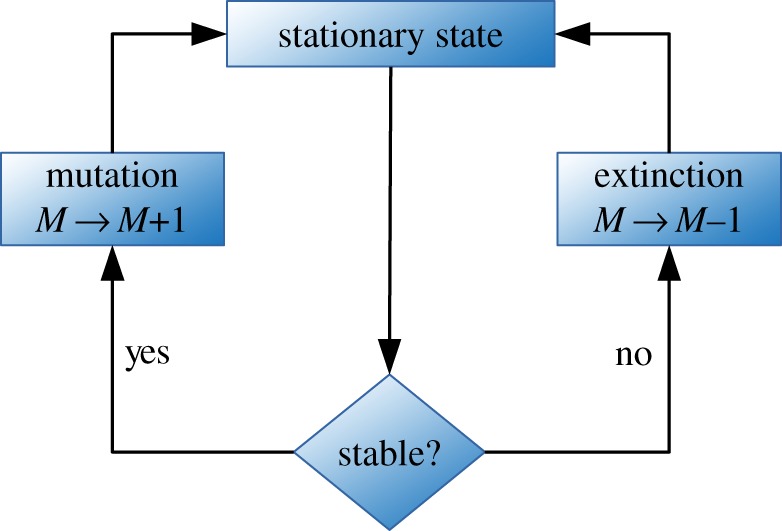
Schematic algorithm for the long-term population dynamics. First, we compute the stationary state of the short-term system according to equation (3.1). Then, we check the stability of the fixed point using the criteria in equation (3.2). If the fixed point is stable (i.e. mating types coexist), a mutation event occurs and we add a novel mating type to the population. If the fixed point is not stable, the mating type with the highest mortality rate goes extinct, i.e. is removed from the population. After each mutation and extinction event, we compute the new stationary state.